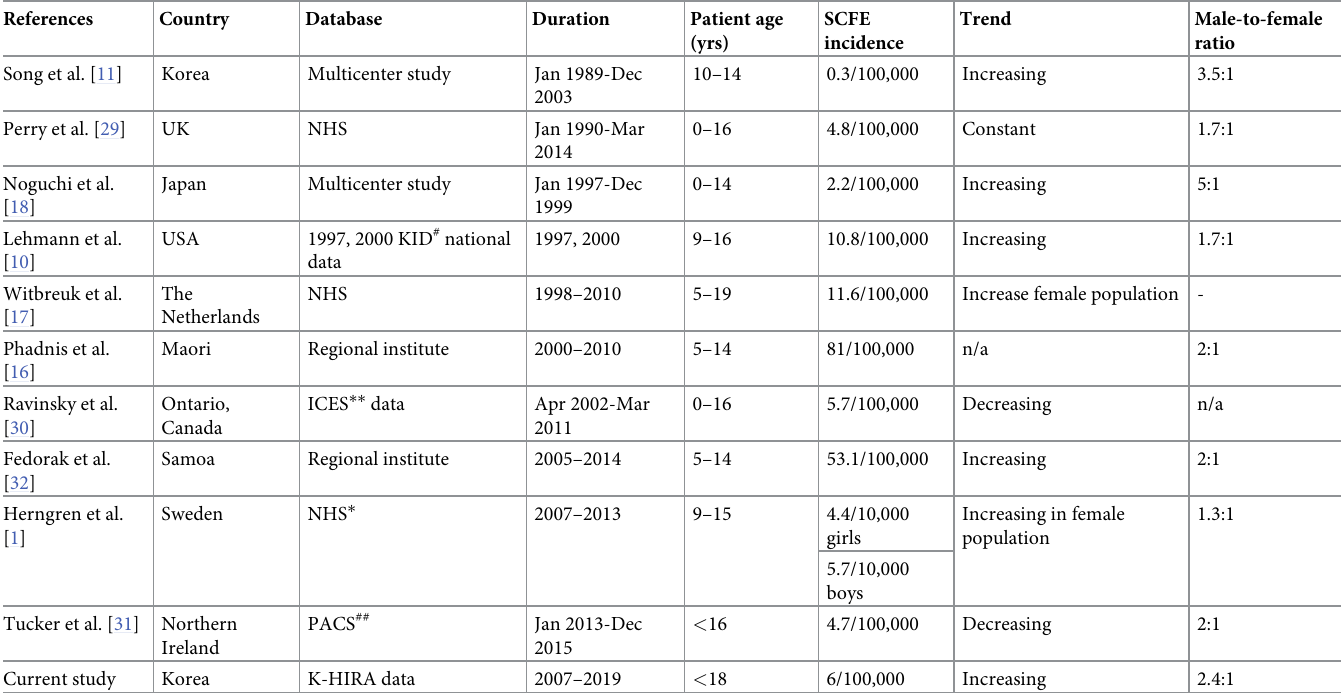
Table 3. Summary of SCFE incidence as noted in previous